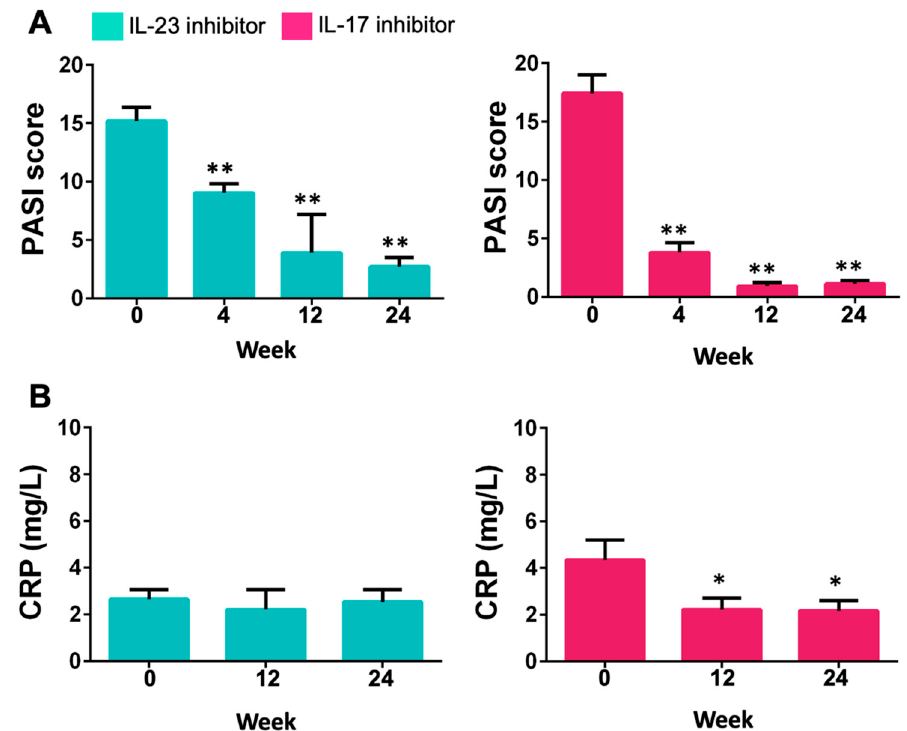
Figure 1. PASI scores ( A ) and CRP levels ( B ) at different time points after the treatment with IL-23 (guselkumab) or IL-17 (secukinumab and ixekizumab) inhibitor. * p < 0.05 versus week 0 for each group; ** p < 0.001 versus week 0 for each